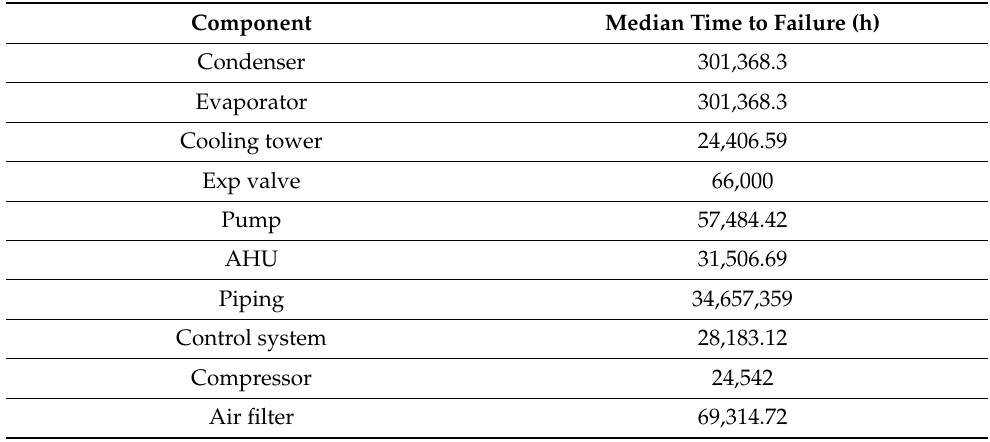
Table 4. List of median time to failures for each component in the system.